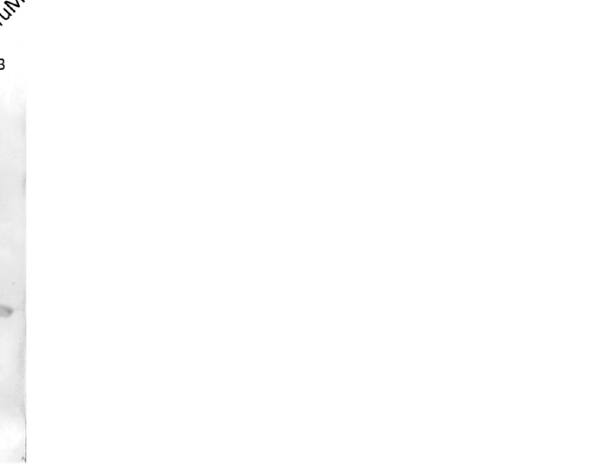
Figure 7. Representative immunogold electron microscopy micrographs of the two co-agroinfil- trated constructs of TuMV VLPs-VIP using SpyTag/SpyCatcher technology. Both constructs were decorated with anti-VIP as a primary antibody and gold-labelled anti-rabbit for decoration. The red arrows highlight the gold nanoparticles attached to the VLPs. Interaction between eVLPs with anti- VIP antibody could only be demonstrated in the ST-CP + SC-VIP construct (central panel). ST: SpyTag; SC: SpyCatcher; CP: TuMV capsid protein; VIP: vasoactive intestinal peptide; C-: negative control of an eVLP without immunogold decoration. 4. Discussion The functionalization of VNPs is a key step to create novel nanotools out of viral structural proteins. In the case of TuMV, the SpyTag/SpyCatcher technology represented the best alternative for potential extensive surface coverage with a protein of interest com- pared with genetic fusion, as it allows the coating of the VLPs while presenting no steric hindrances to the self-assembly of the capsid proteins. Direct fusion of peptides or proteins via genetic fusion has long been used because it is a simple, effective, and selective method for functionalizing VLPs [4]. As in the case of GFP and VIP, the protein of interest is fused to a CP domain projected towards the exterior